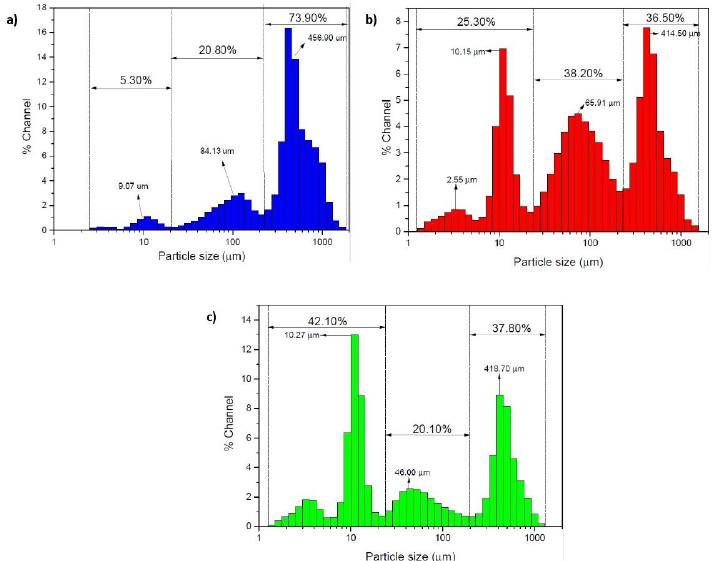
Figure 5: Granulometric distribution of the Vanadis ® 8 milled with VC addition for (a) 4 hours (b) 8 hours (c) 12